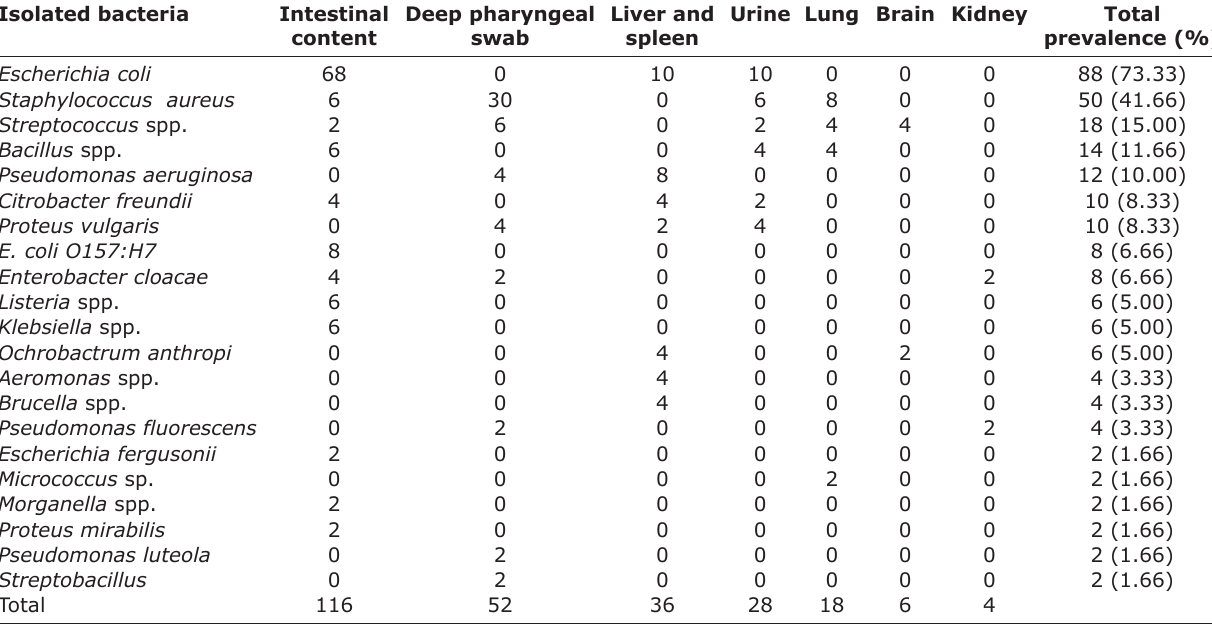
Table-1: Bacterial isolates from the internal organs of captured rats. Isolated